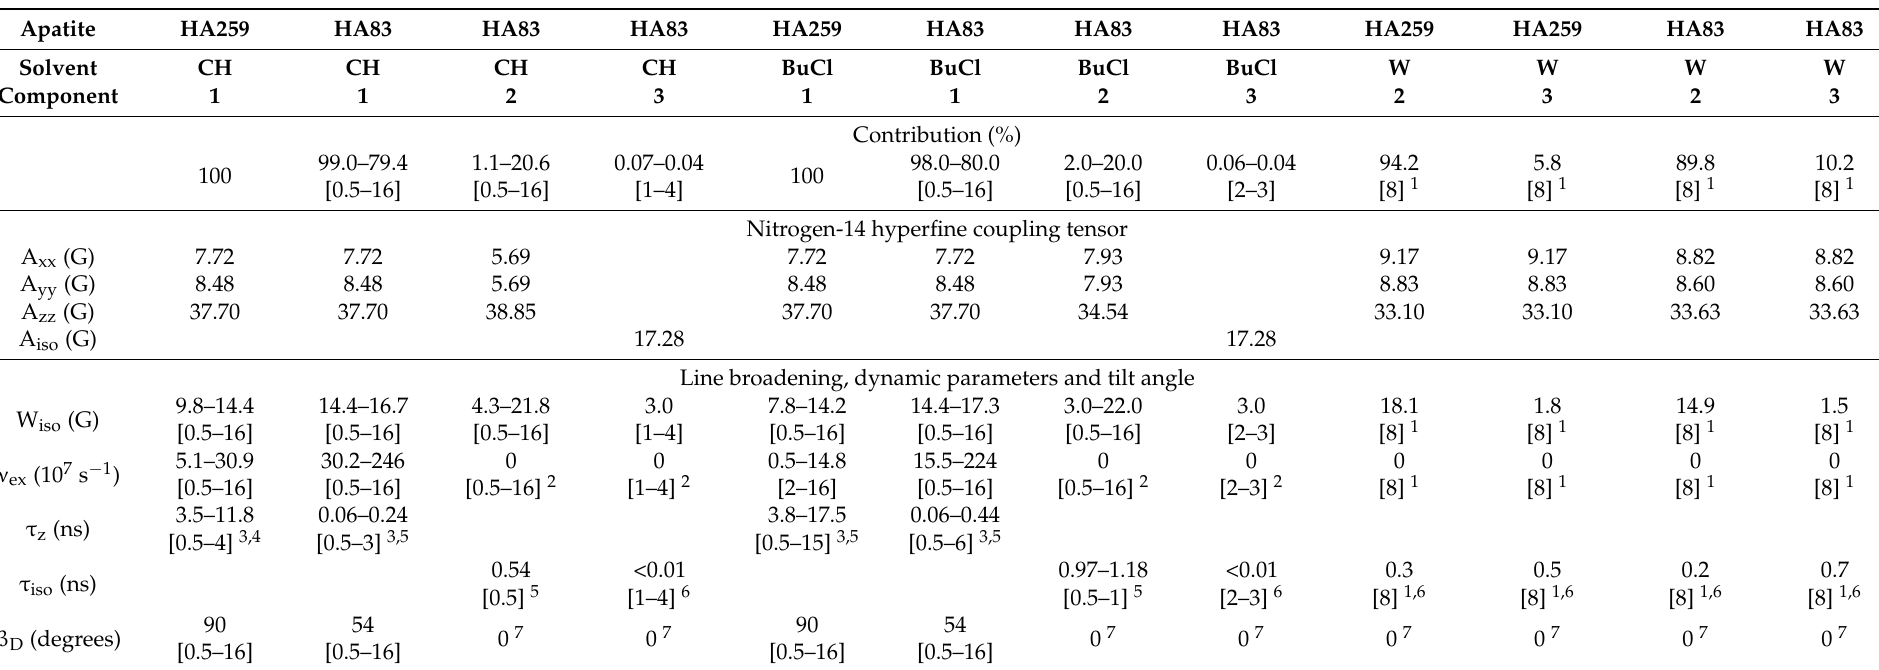
Table 4. EPR parameters of TEMPO for its composites containing HA259 and HA83, reported for separate spectral components. The parameters were computed using the MultiComponent program. The g tensor was precisely determined for 0.5 mM HA259/TEMPO(BuCl) and was kept the same for all fittings: g ii = 2.0058, 2.0047 and 2.0014. Concentration ranges of TEMPO (in mM) for variable parameters are given in the square brackets below their extreme values. Component 3 for HA83/TEMPO(CH) and HA83/TEMPO(BuCl) was only detected for the TEMPO concentrations specified in the table for those